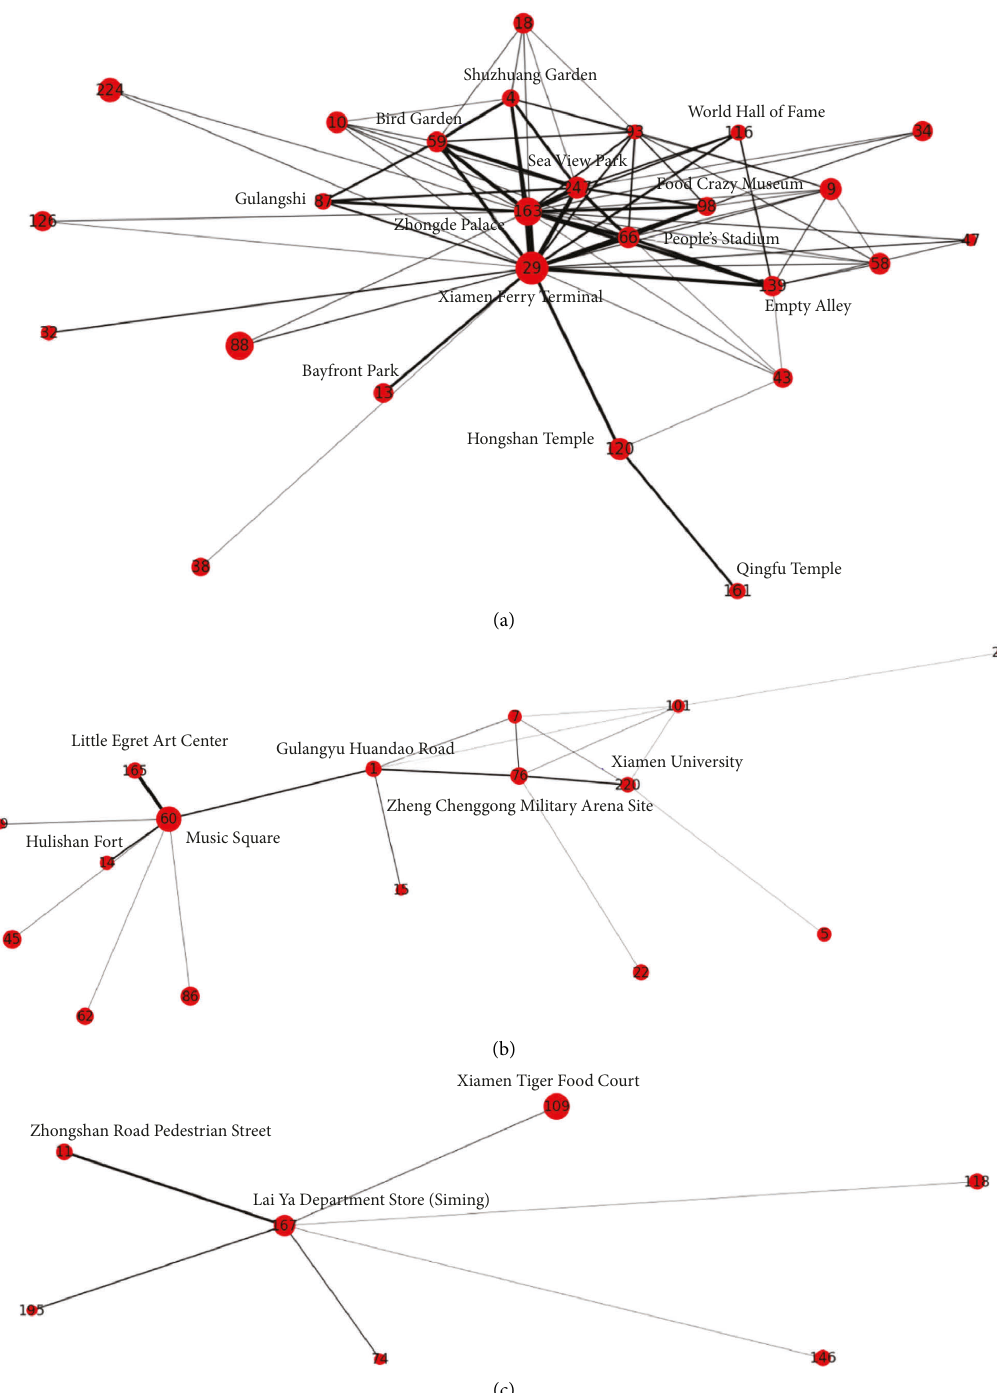
Figure 7: Tourism areas identified in Xiamen. (a) Gulangyu tourism area travel network ( θ � 0 . 35). (c) Zhongshan Road tourism area travel network ( θ ( θ 0